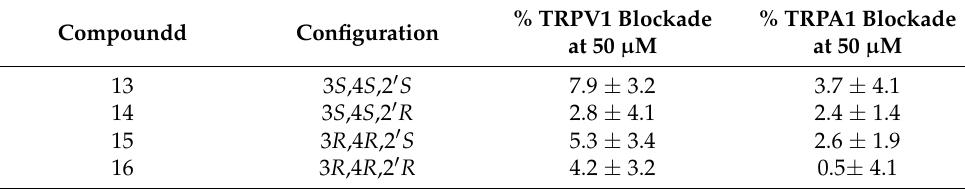
Table 2. Activity at TRPV1 and TRPA1 channels of β –lactam derivatives (Ca 2+ influx assay).